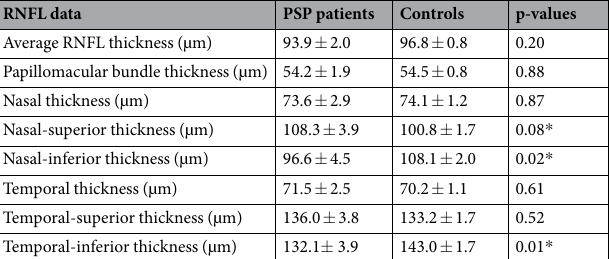
Table 2. OCT RNFL measurements around the optic disc of PSP patients and control probands (mean ± standard error, corrected for age and sex). P-values with significant differences are marked with *